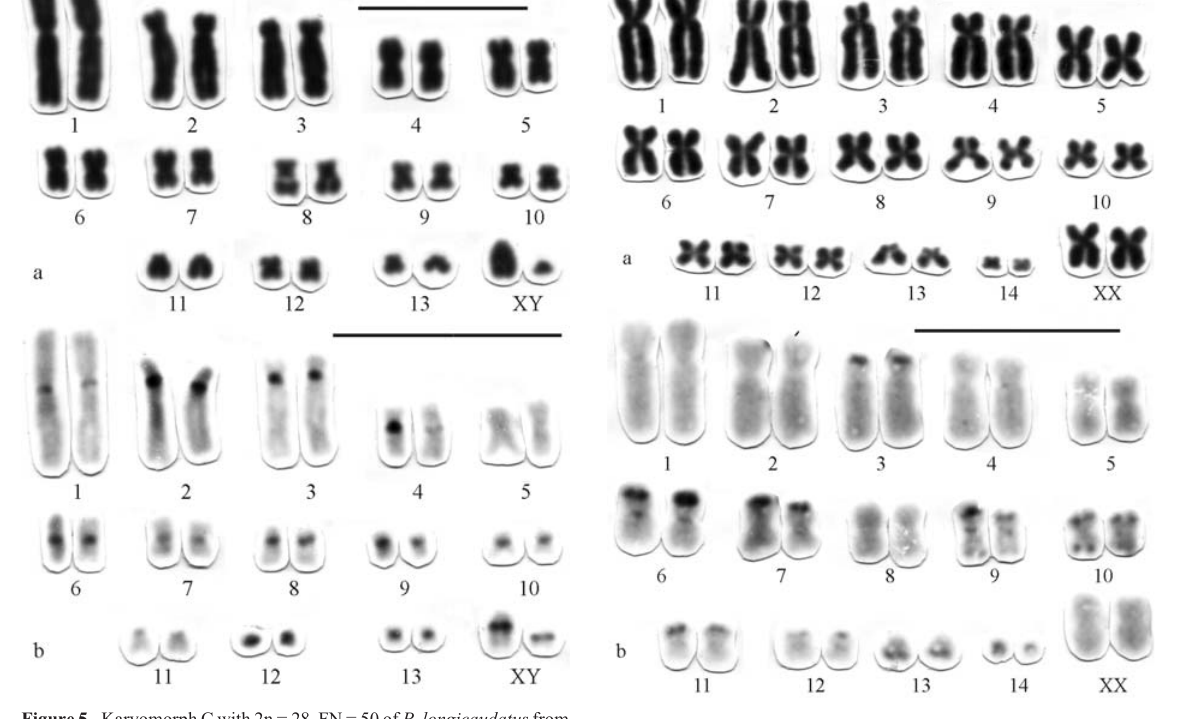
Figure 6 - Karyomorph D with 2n = 30, FN = 56 of P. roberti from Uruçuí-Una (PI): a) Karyotype conventionally stained; b) C-banding pat- tern. Bar = 10 (cid:1)